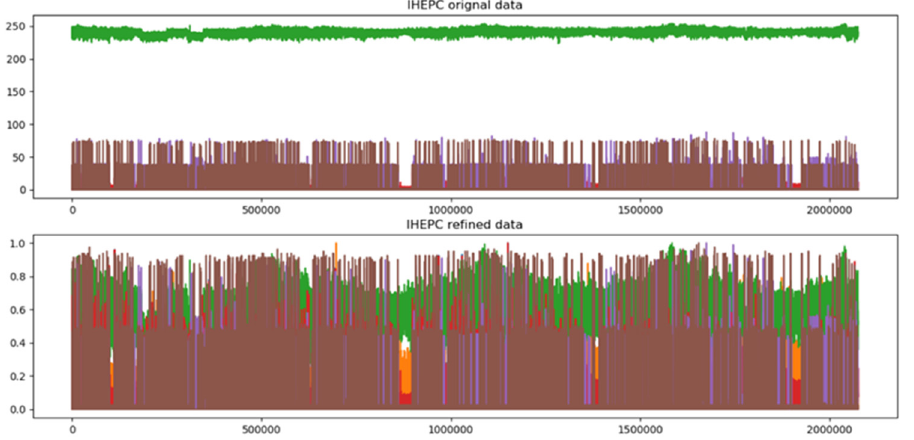
Figure 3. Original and refine data representation of the IHEPC dataset.